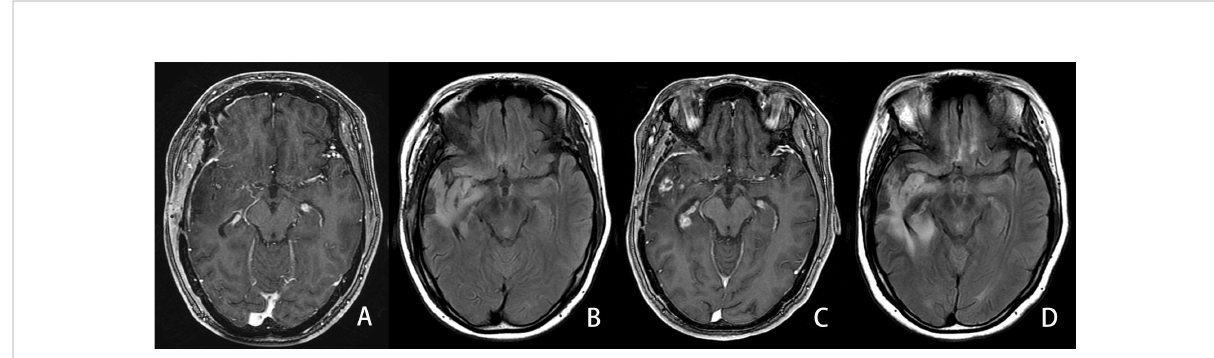
FIGURE 6 Example of an LGG patient in the progressed group. A 34-year-old man with diffuse IDH wild-type astrocytoma in his right temporal lobe. The PFS and OS were 339 and 1,035 days, respectively. A, (B) First follow-up MRI after the completion of radiotherapy. (A) Axial CE-T1WI does not show enhancement in the region corresponding to FLAIR hyperintensity. (B) Axial FLAIR images show the residual cavity and the surrounding hyperintensity lesion. C, (D) Follow-up MRI 25 months after the completion of radiotherapy. (C) CE-T1WI shows new developed ring and curved linear enhancement. (D) Axial FLAIR images show the prominent enlargement (42%) of the hyperintensity lesion surrounding the residual cavity.